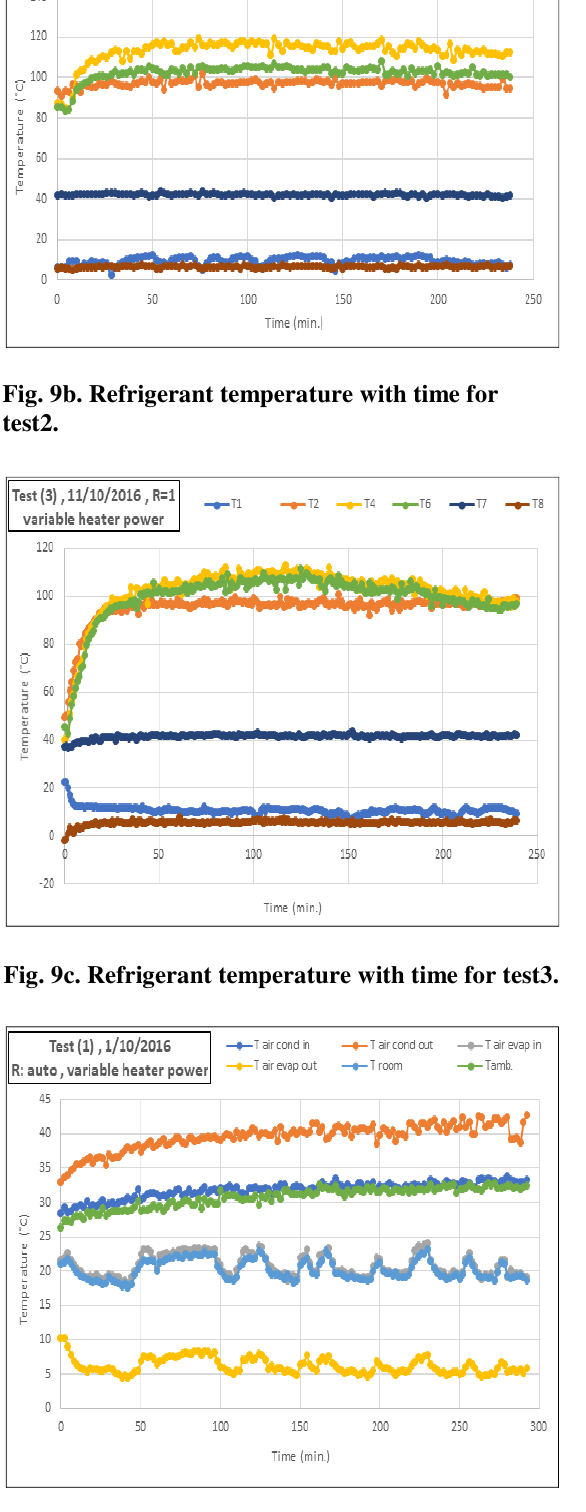
Fig. 11a. Refrigerant pressure and volumetric flow rate with time for test